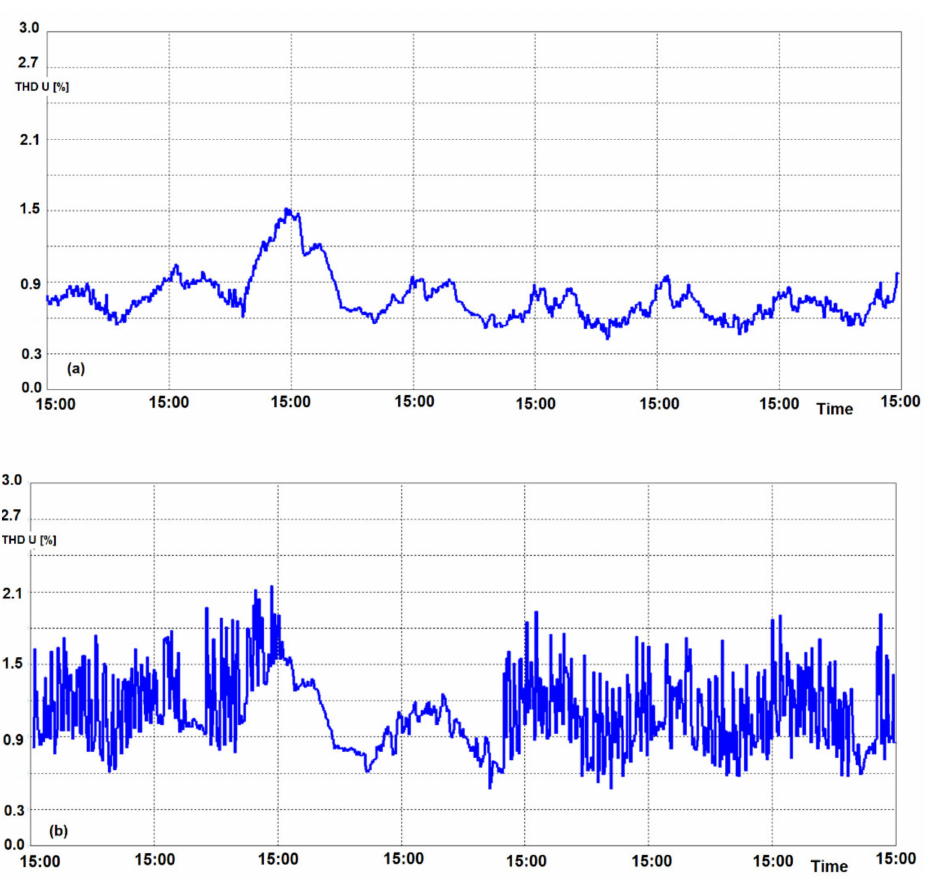
Figure 19. Changes of total harmonic distortion (THD) recorded at the same time in points with different short-circuit powers: ( a ) S cc /S ntr = 150, ( b ) S cc /S ntr = 20. The results of the statistical analysis of voltage fluctuations are presented